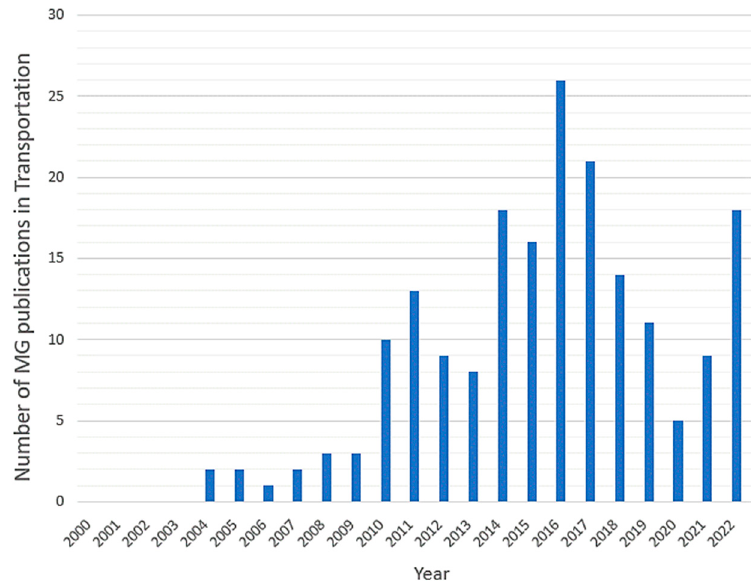
Figure 18. Publications of MGs applications in Transportation.